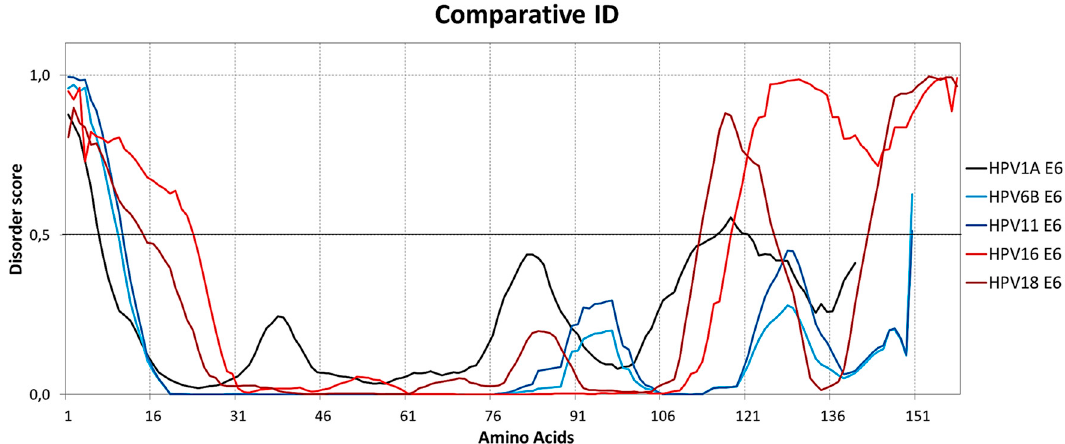
Figure 4. Comparison of intrinsic disorder between E6 of HPV16 and HPV18 (high-risk), HPV6B and HPV11 (low-risk), and HPV1A (control). High-risk HPV16 and HPV18 E6 proteins have considerably longer regions of intrinsic disorder at both ends, especially at the C-terminus. The dashed lines at 0.5 of y -axis are threshold lines for disordered/structured residues. Residues with a score above this line are predicted disordered, and residues with a score below 0.5 are predicted to be ordered. These results were obtained using the PONDR-FIT tools [21].